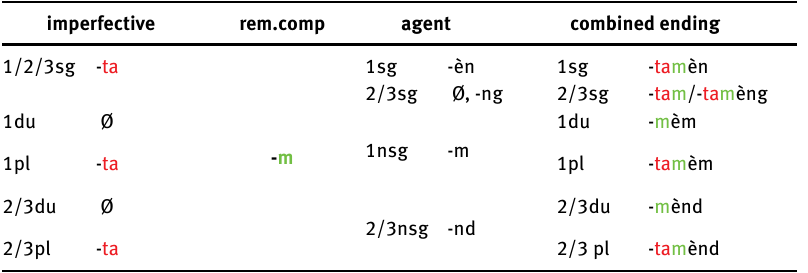
Table 5: Remote completive suffixes